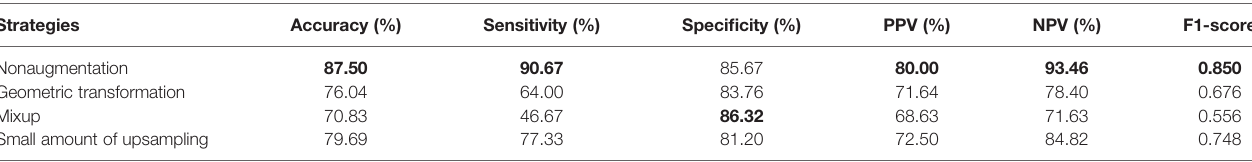
Values in bold black font represent the best performance in each